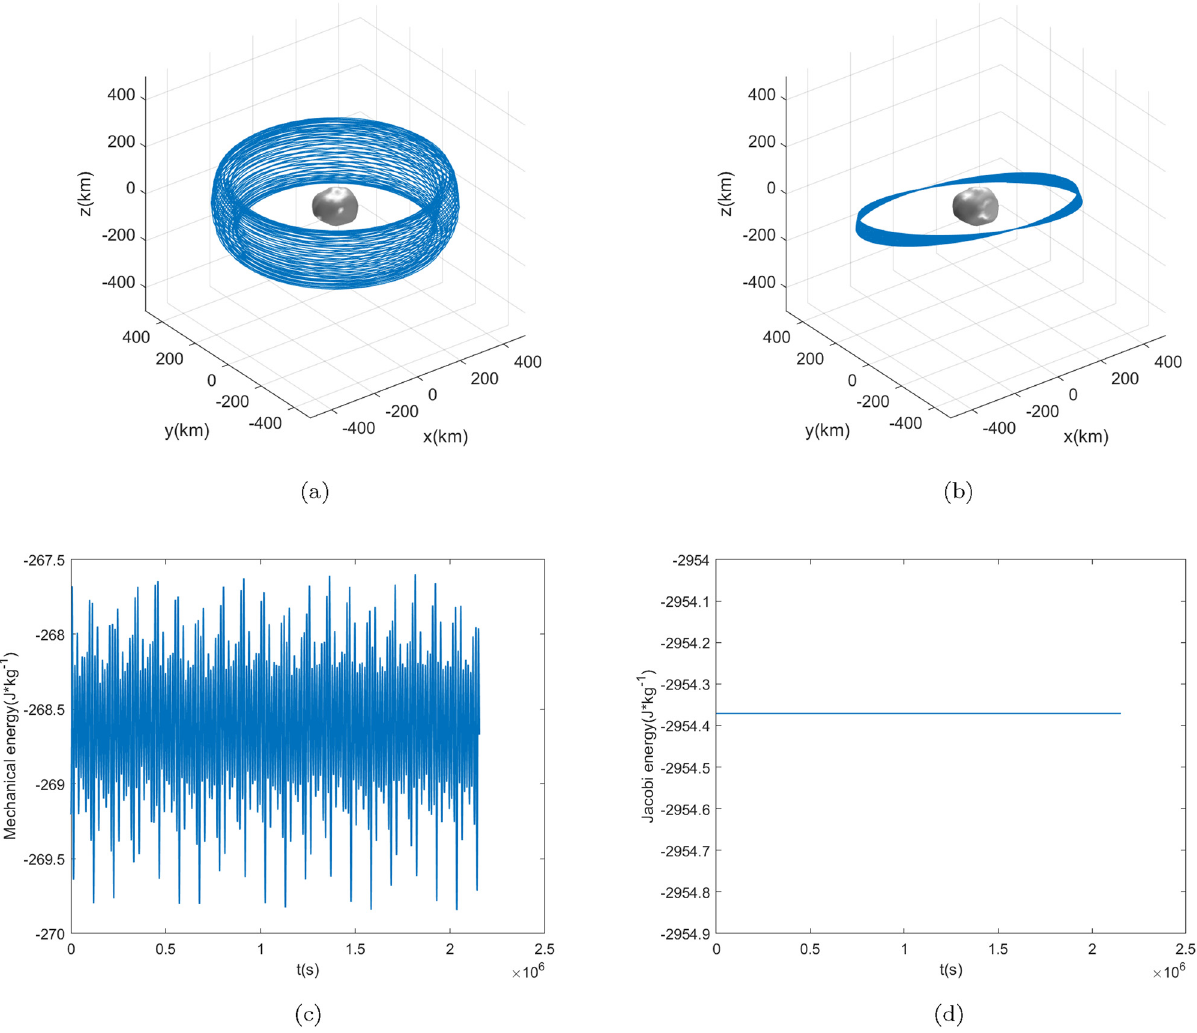
Figure 7: Orbit simulation of Minerva moonlet. ( a ) 3D map of the orbit in the body - fi xed coordinate system. ( b ) 3D map of the orbit in the inertial system. ( c ) Mechanical energy of the orbit. ( d ) Jacobian integral of